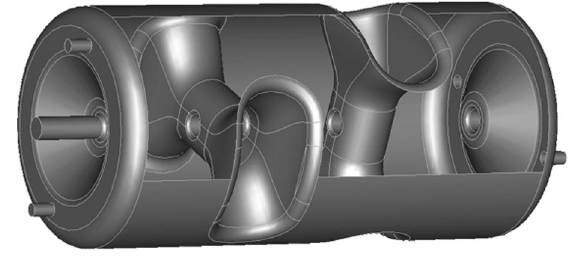
FIG. 1. 325 MHz, (cid:1) 0 ¼ 1 double-spoke